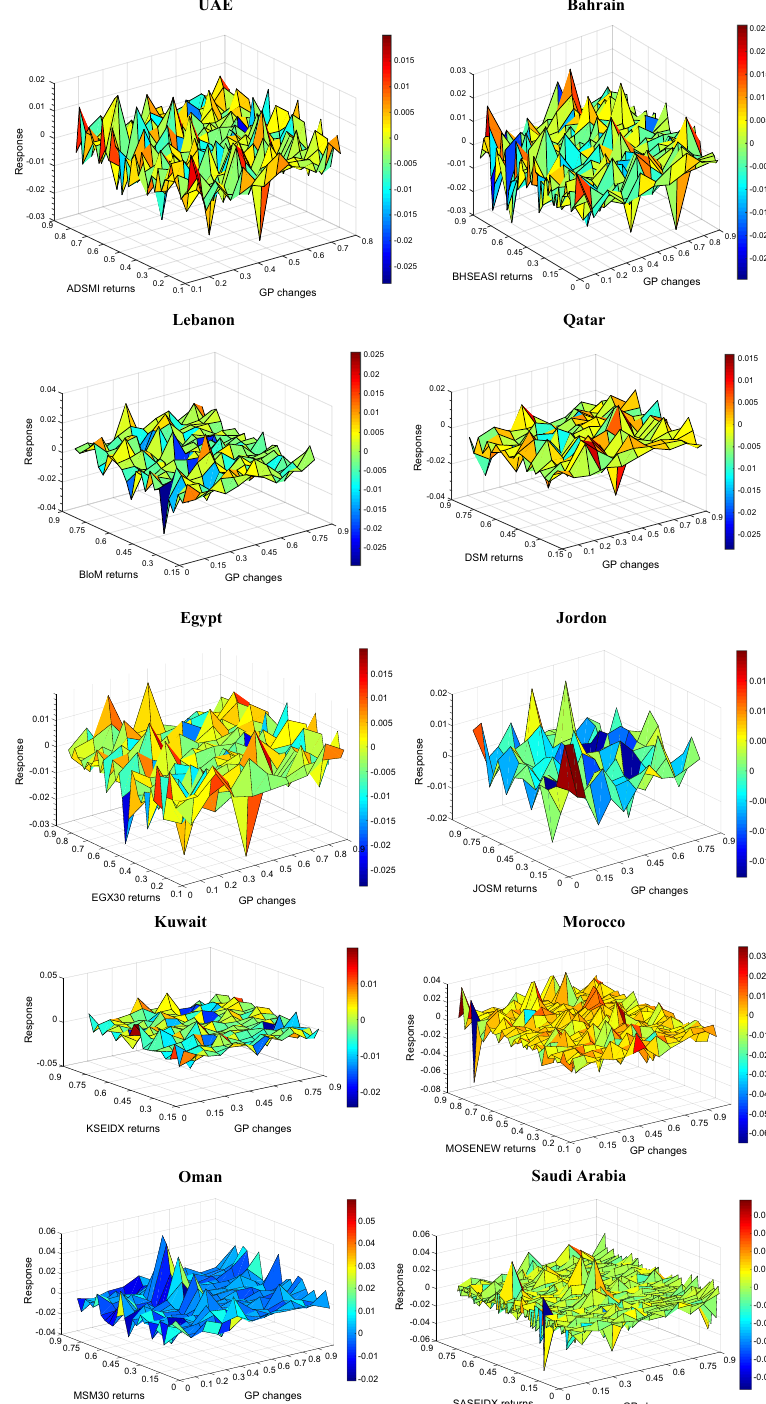
Fig. 3 Copula quantile-on-quantile (C-QQR) between MENA gold and stock